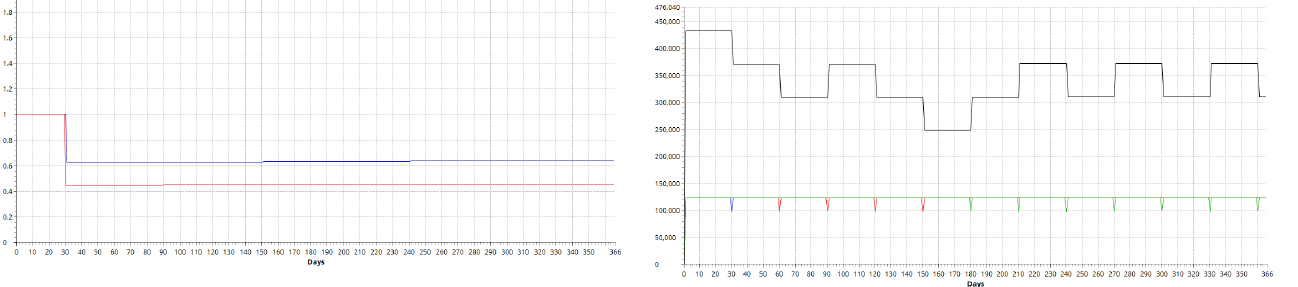
Figure 20. Service Level of Scenario II.